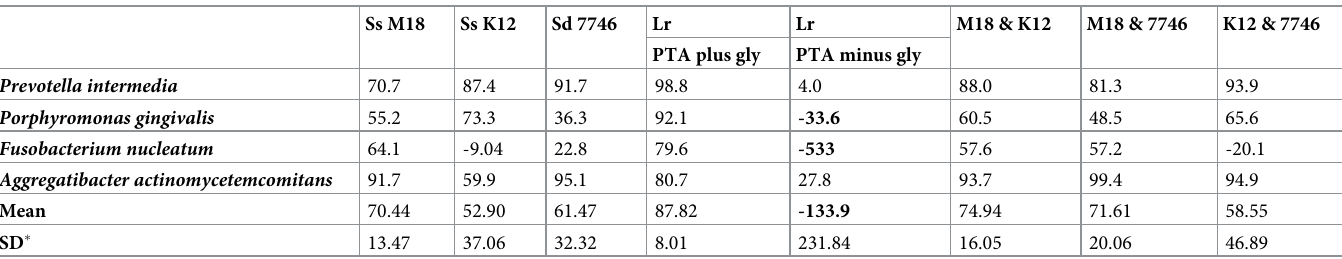
Table 2. Inhibition (in %) of four different periodontopathogenic species by four oral probiotic strains and single or in different